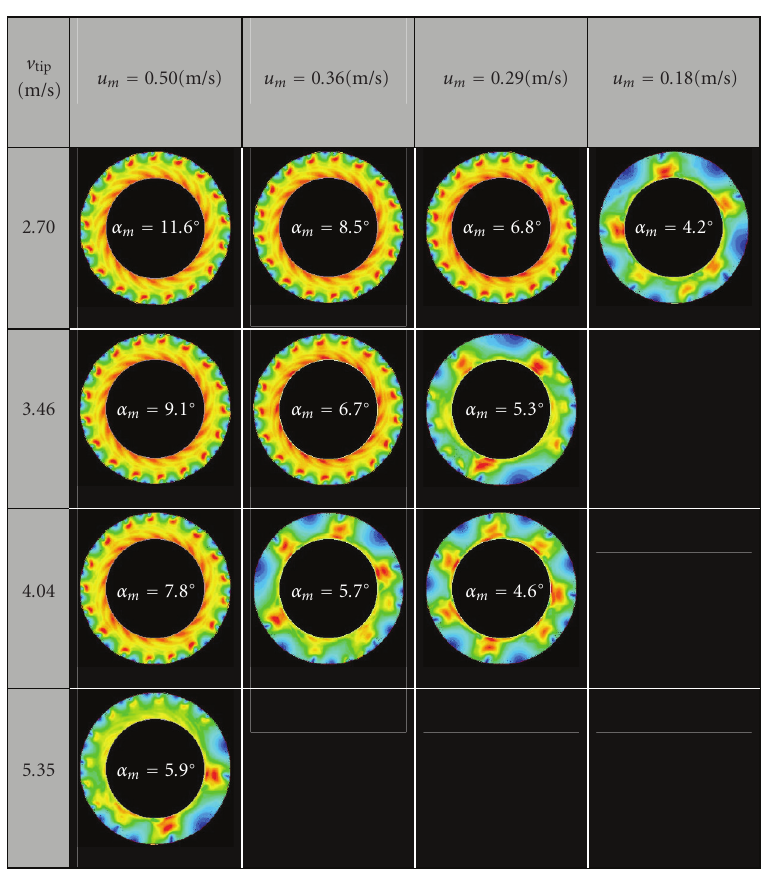
Table 1: The stability